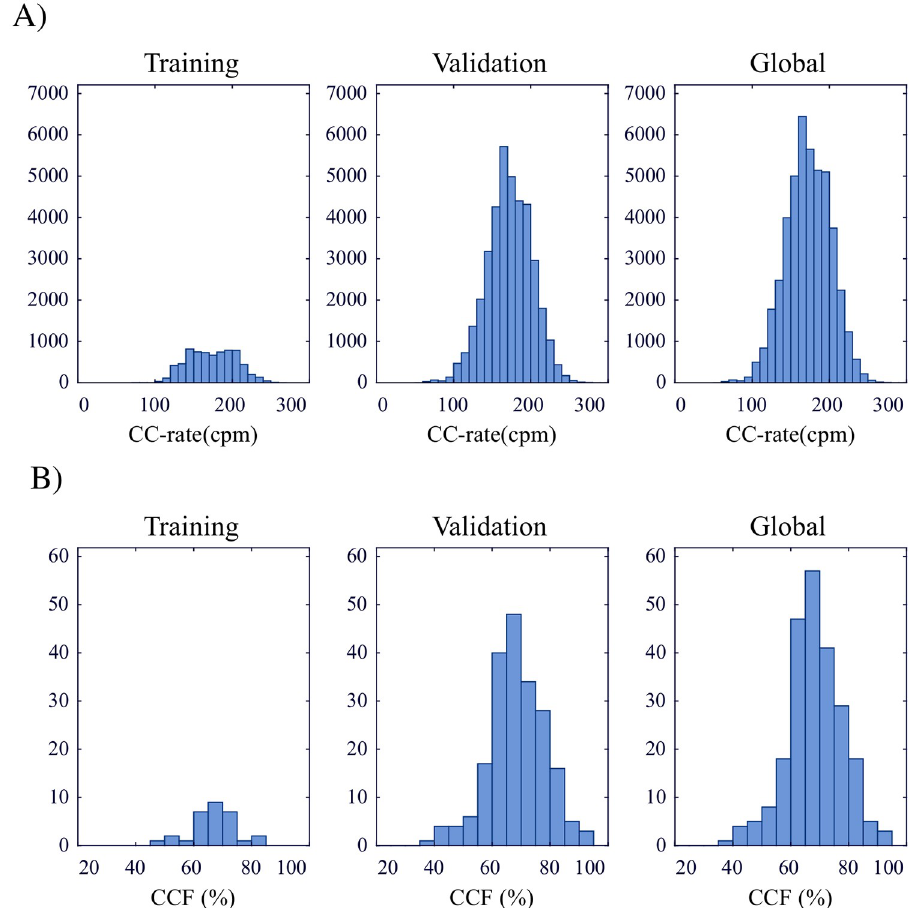
Fig 2. Distributions of chest compression rate (CC-rate) (A) and CCF (B) in the training and validation subsets and global distributions (both subsets jointly). Values were computed from the reference standard